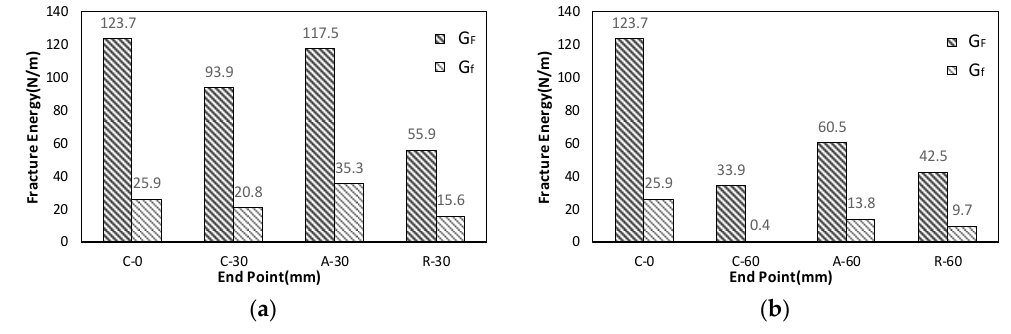
Figure 15. Comparison of G F and G f : ( a ) C-0, C-30, A-30 and R-30; and ( b ) C-0, C-60, A-60 and R-60. Table 3. All Results obtained from fracture energy test.